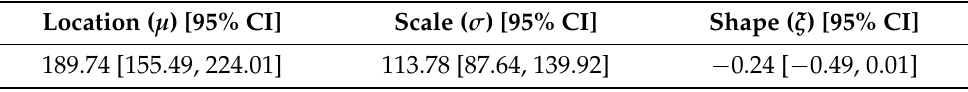
Table 1. Estimates and their 95% CIs of three GEV parameters obtained by bootstrapping.